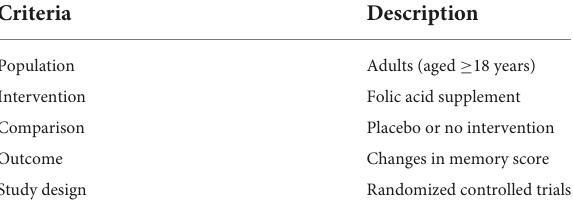
TABLE 1 The population, intervention, comparison, outcome, study design (PICO)